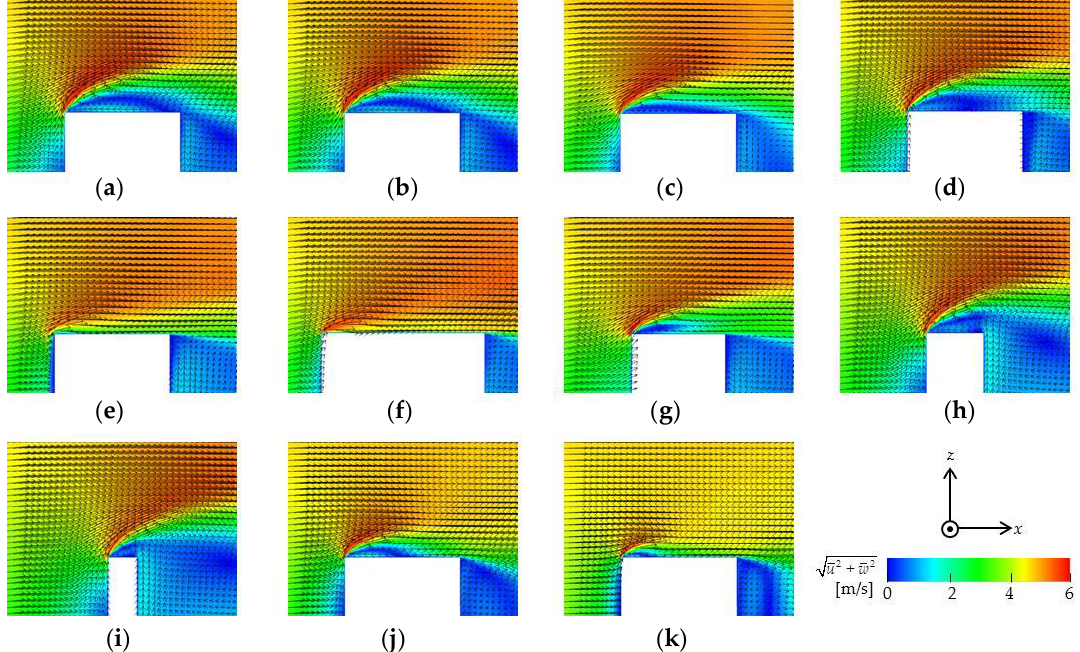
Figure 6. Vertical distributions of the wind vectors along the dotted lines indicated in Figure 5. ( a ) Line i; ( b ) Line ii; ( c ) Line iii; ( d ) Line iv; ( e ) Line v; ( f ) Line vi; ( g ) Line vii; ( h ) Line viii; ( i ) Line ix; ( j ) Line x; ( k ) Line xi.